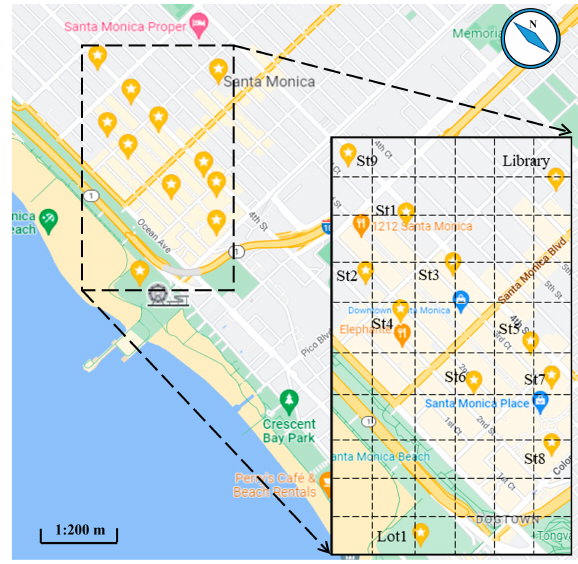
Figure 1. Distribution of parking lots in the region.